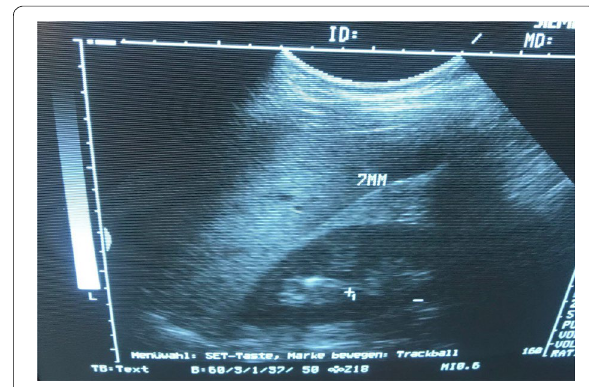
Fig. 1 Ultrasound right upper pole small renal stone